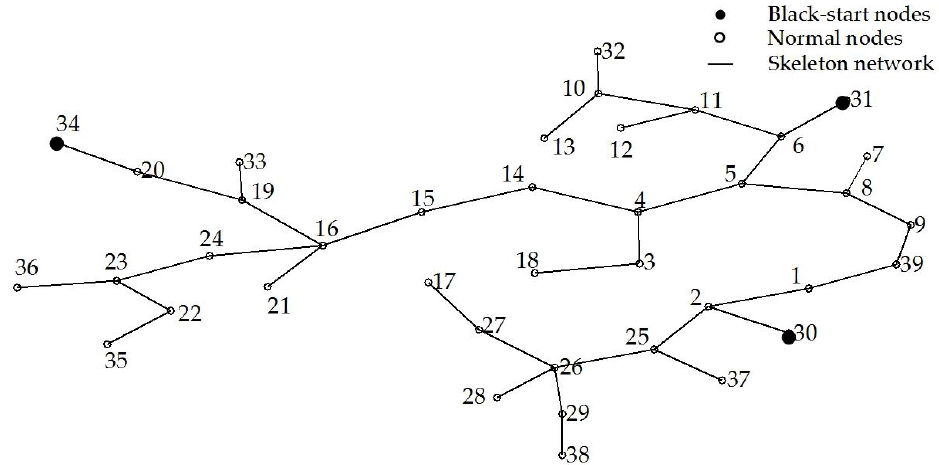
Figure 5. The skeleton network of IEEE 39-bus test system.